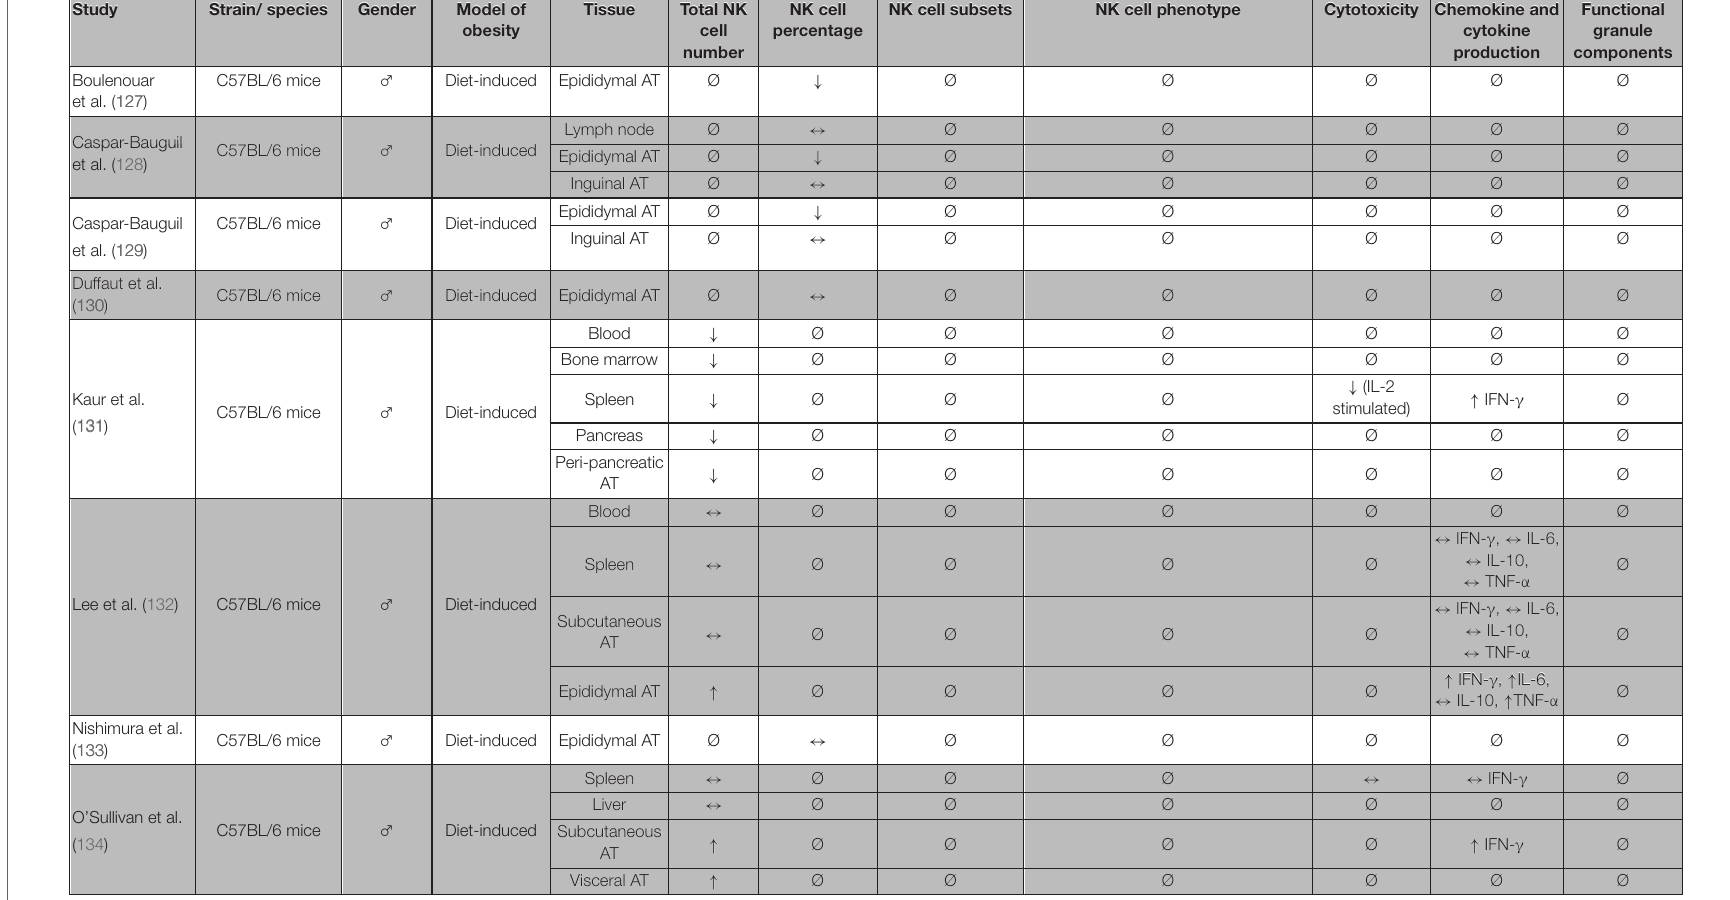
TABLE 3 | Overview of animal studies investigating the effect of obesity on number, subsets, phenotype, and functional parameters of NK cells in different tissues.